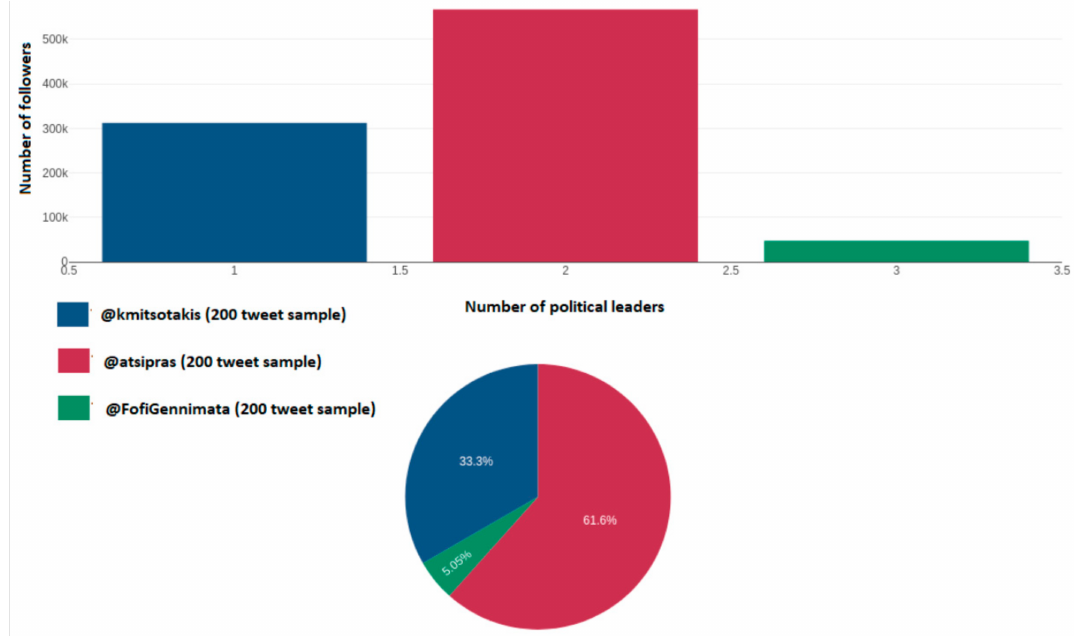
Figure 24. Number of registered subscribers per Twitter account for the top three Greek political